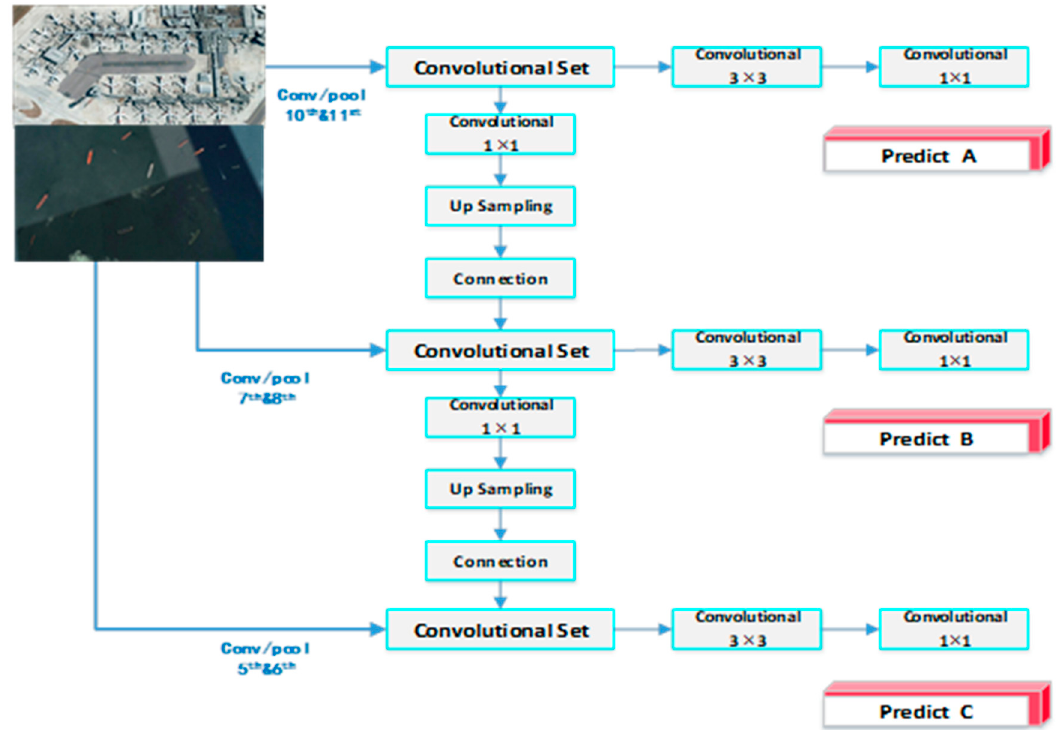
Figure 5. Feature extraction diagram of the proposed TF-YOLO network.